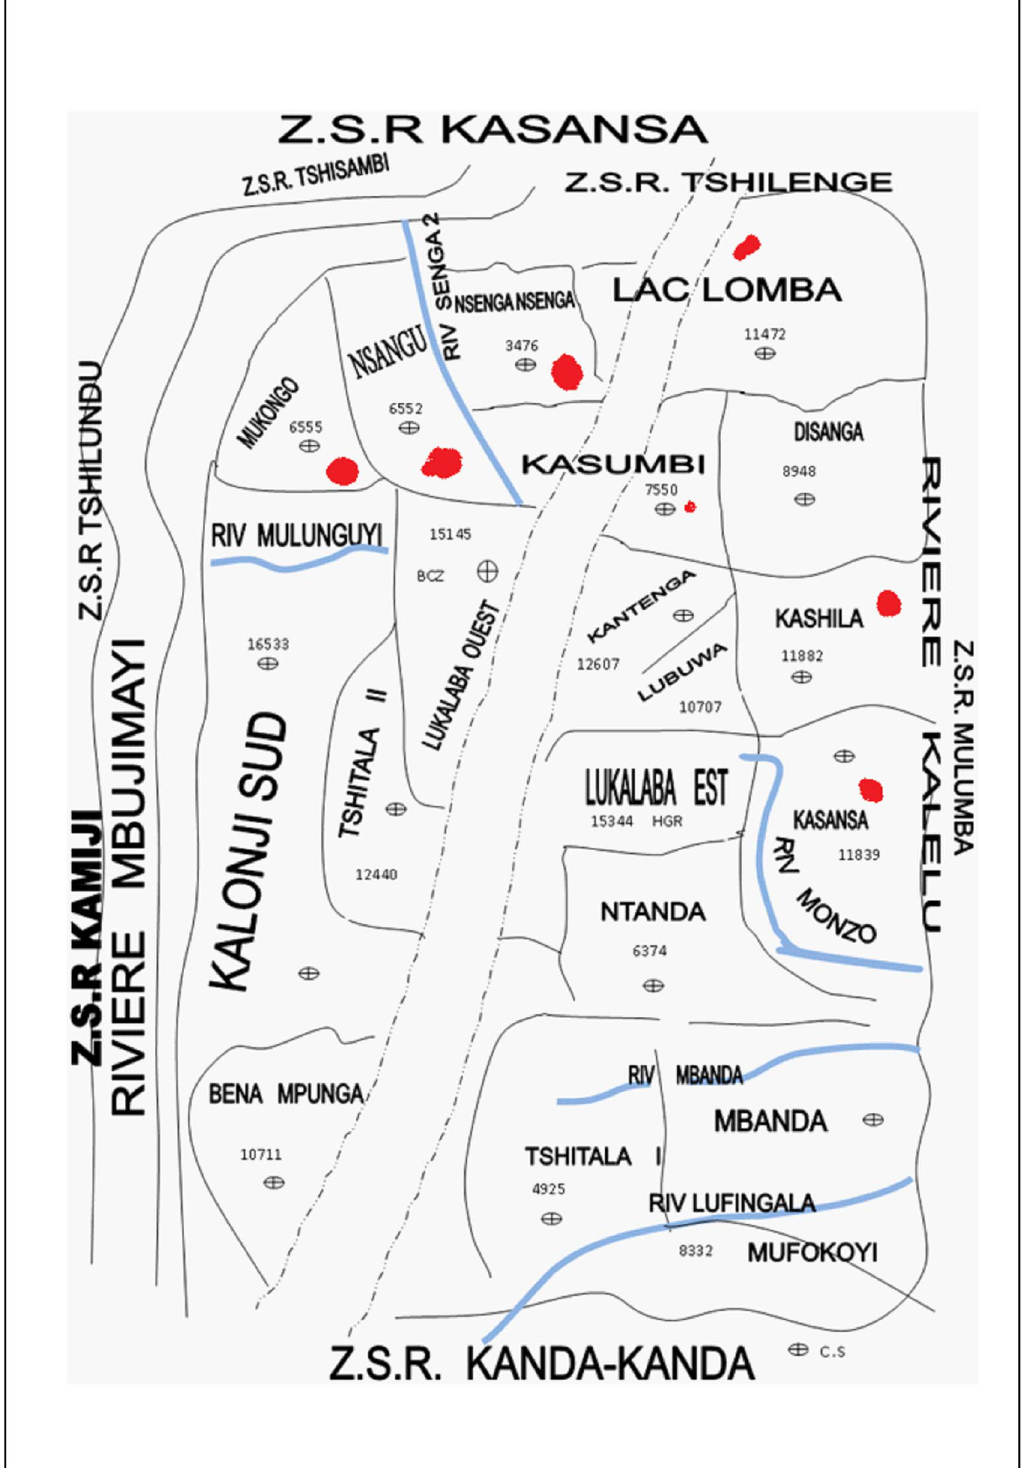
Fig. 2. The health zone of Kasansa, red dots indicate the studied health areas.